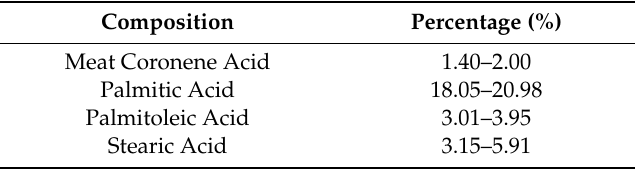
Table 2. Chemical compositions of Wei Lih fragrance oil used in this study (inflow parameters values are 15 mg / L, 30 mg / L, 60 mg / L, and 120 mg /